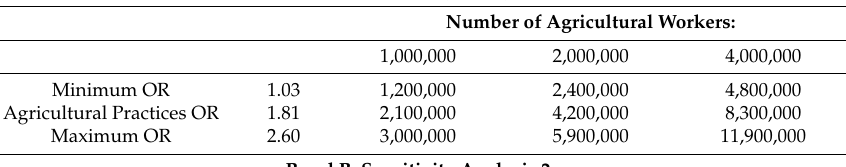
Table 4. Sensitivity Analyses of Total Benefits of the new WPS for Agricultural Workers ($). Panel A: Sensitivity Analysis